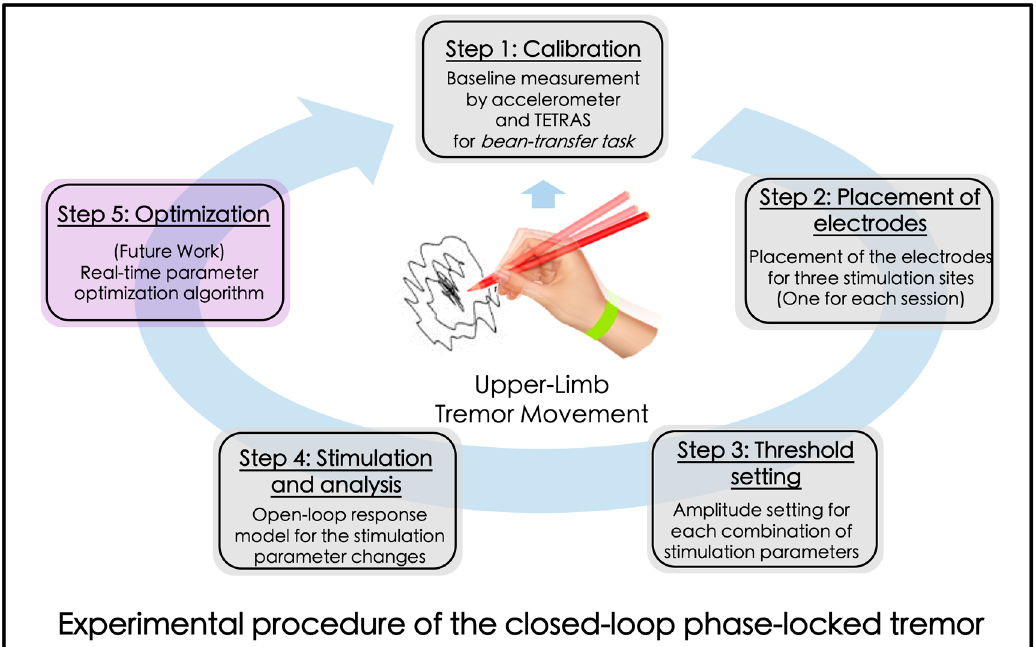
Figure 1. Experimental procedure for the analysis of the effects of the stimulation parameters using the tremor monitor and modulation system.